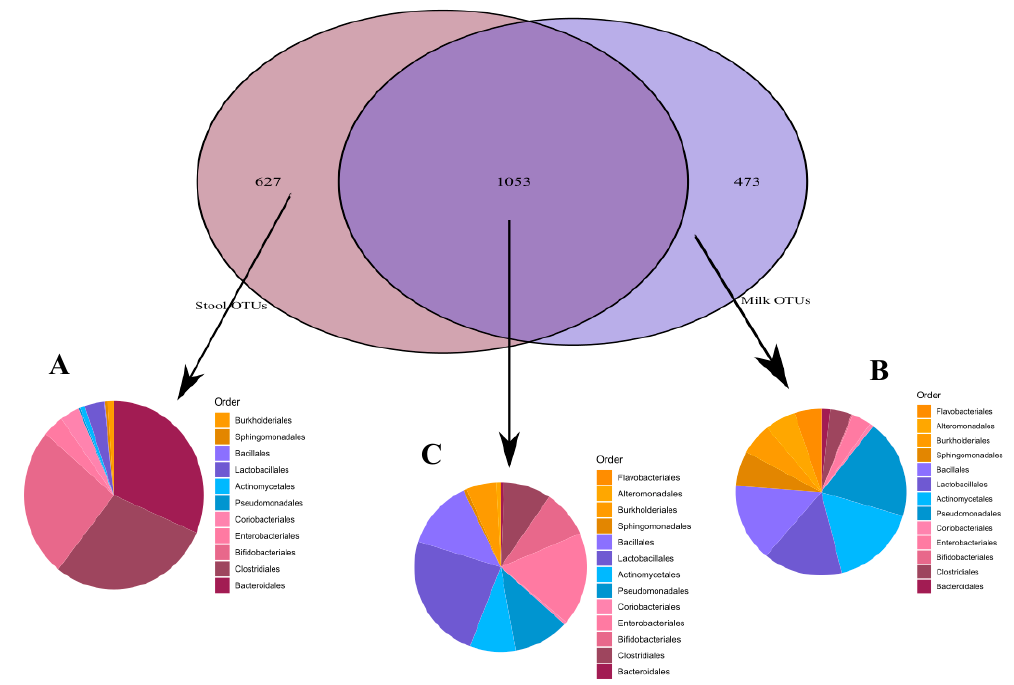
Figure 2. Operational taxonomic units (OTUs) order-level taxonomical assignments. ( A ) Stool-unique OTUs; ( B ) Milk-unique OTUs; ( C ) Shared OTUs (OTUs appearing in at least one milk and one stool sample) .